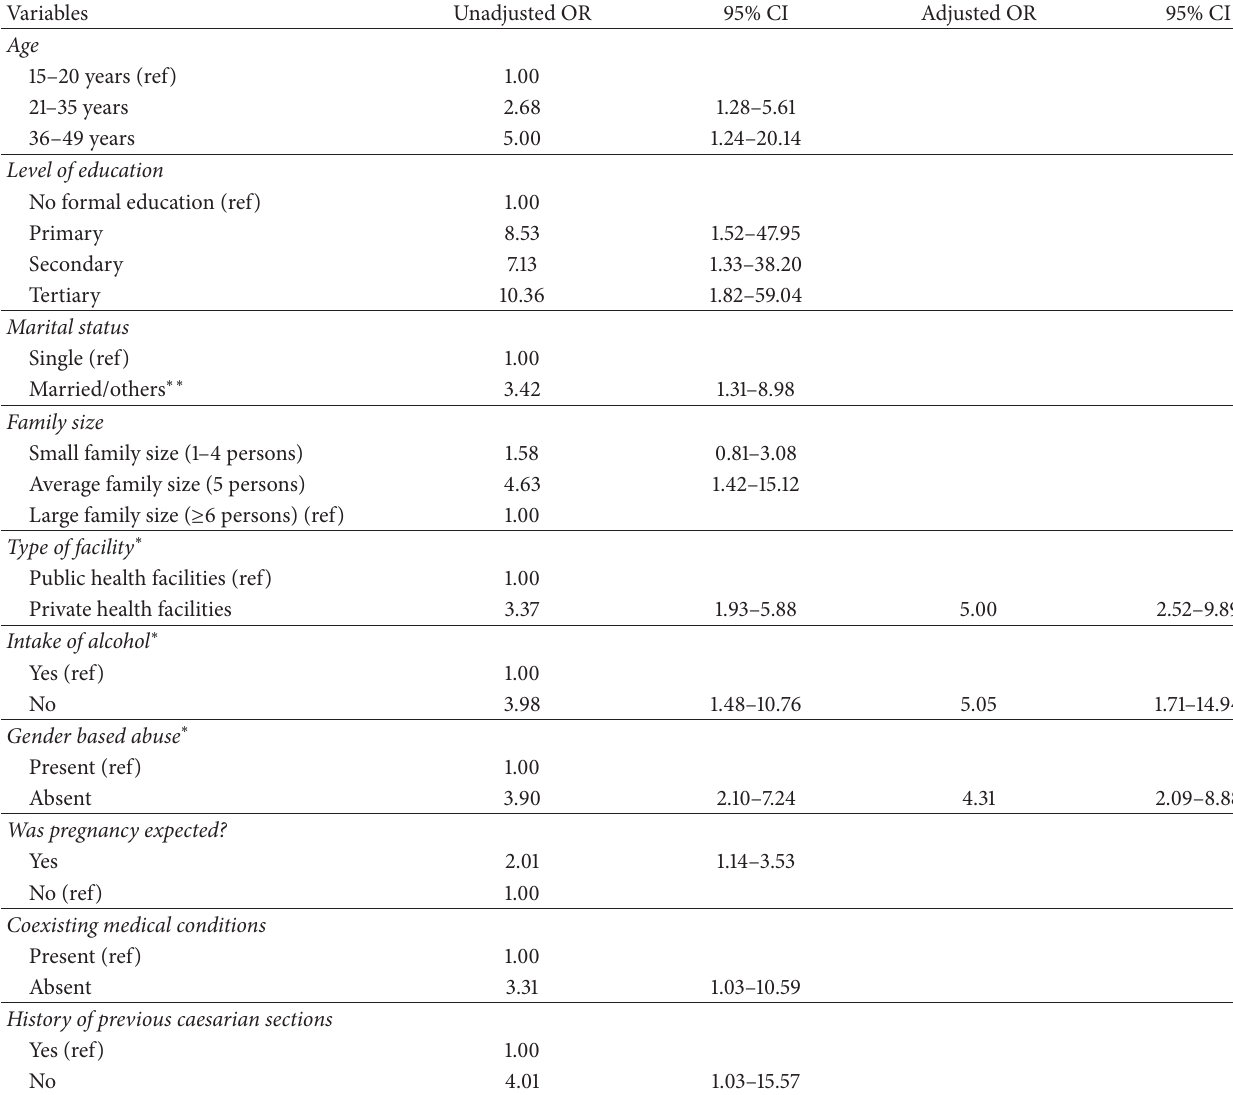
Table 5: Results of multiple regression for predictors of antenatal